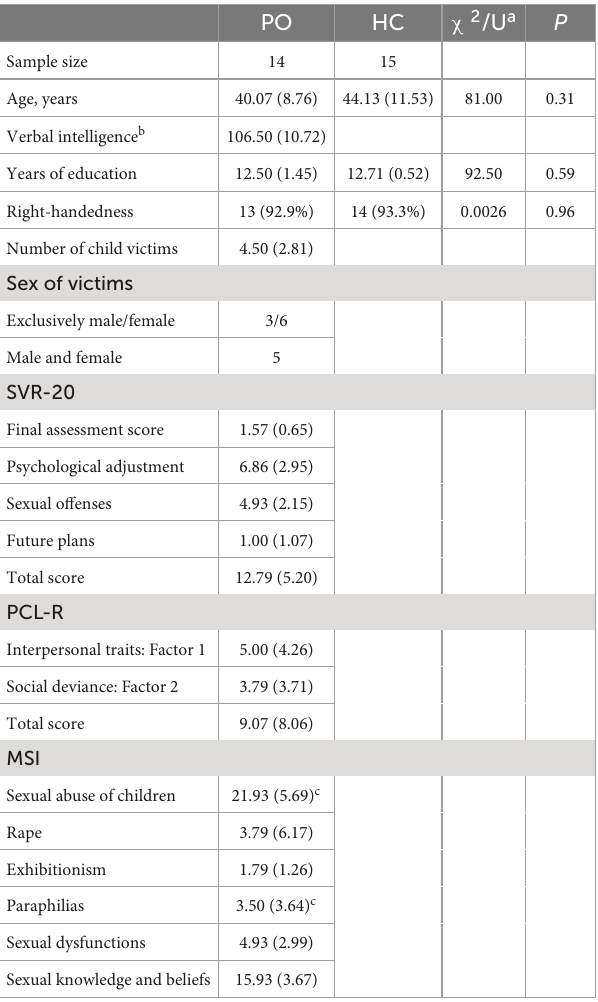
TABLE 1 Clinical and sociodemographic characteristics of the study